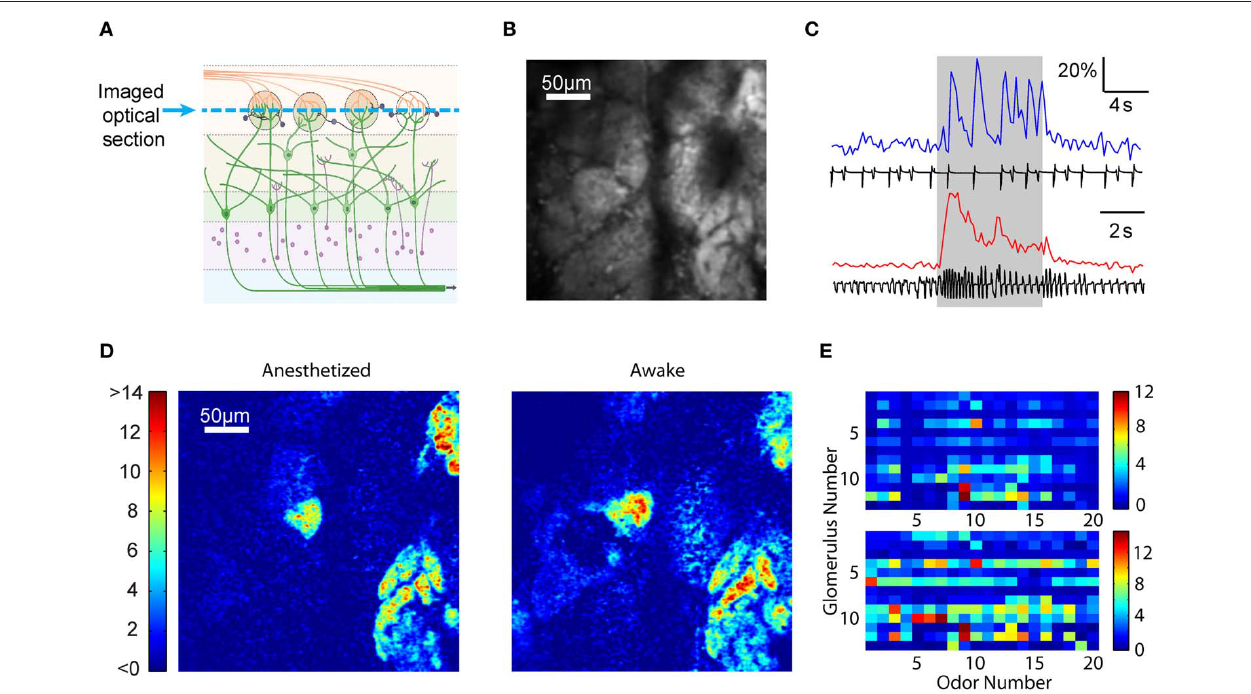
FIGURE 5 | Multi-photon optical sectioning confirms the consistency of glomerular activation across states. (A) Schematic from Figure 1A depicting optical sectioning. Multi-photon microscopy excludes light from other layers, resulting in an image consisting only of a thin layer (blue dashed line). (B) Multi-photon image showing the resting activity of the glomerular layer. (C) Fluorescence time courses and sniff plots for an anesthetized (top) and an awake (bottom) mouse. Consistent with findings from wide-field microscopy,